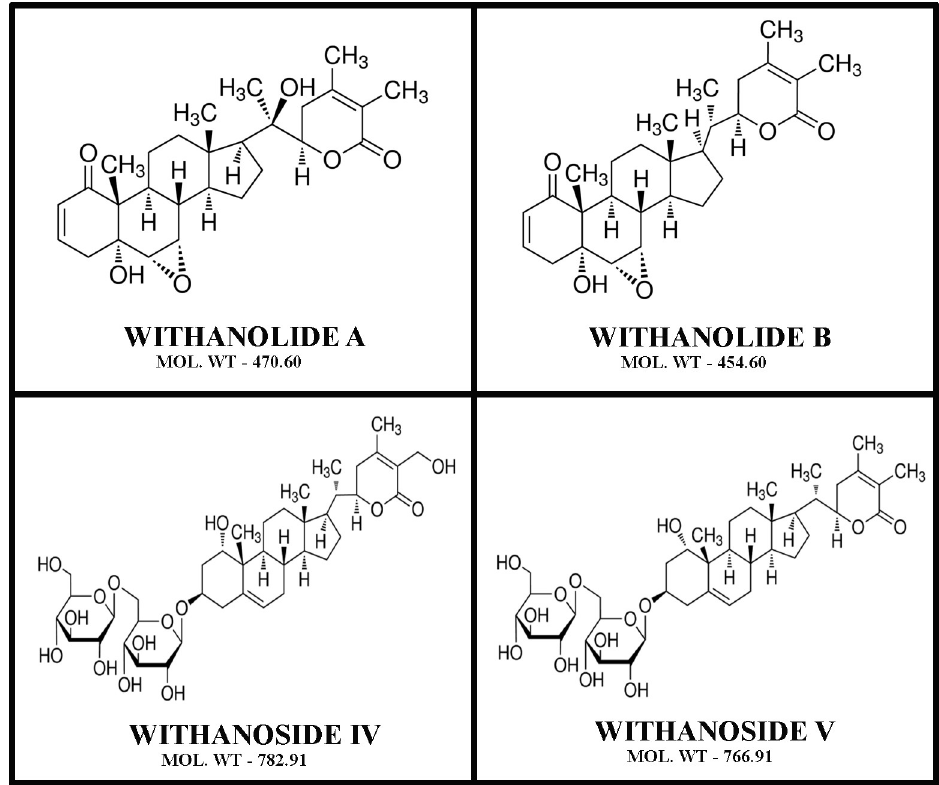
Fig 1. The structure of withanolide A (C 28 H 38 O 6 -470.6Da), withanolide B (C 28 H 38 O 5 -454.6Da), withanoside IV